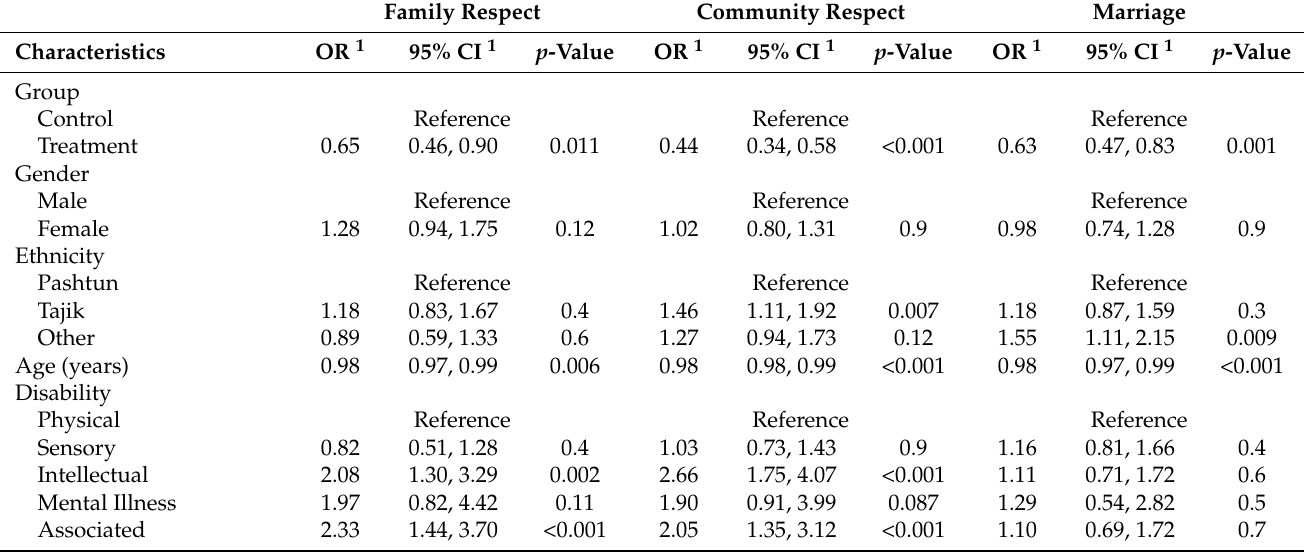
Table 6. Results of logistic models on family or community respect and marriage